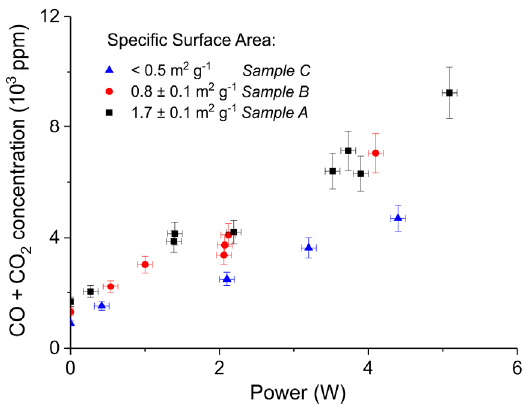
Figure 6. Sum of CO 2 and CO concentrations plotted as function of power obtained during decomposition of CaCO 3 samples A, B, and C with different surface areas; all the experiments performed at 630 °C, in pure argon, and flow rate 30 mL/min.